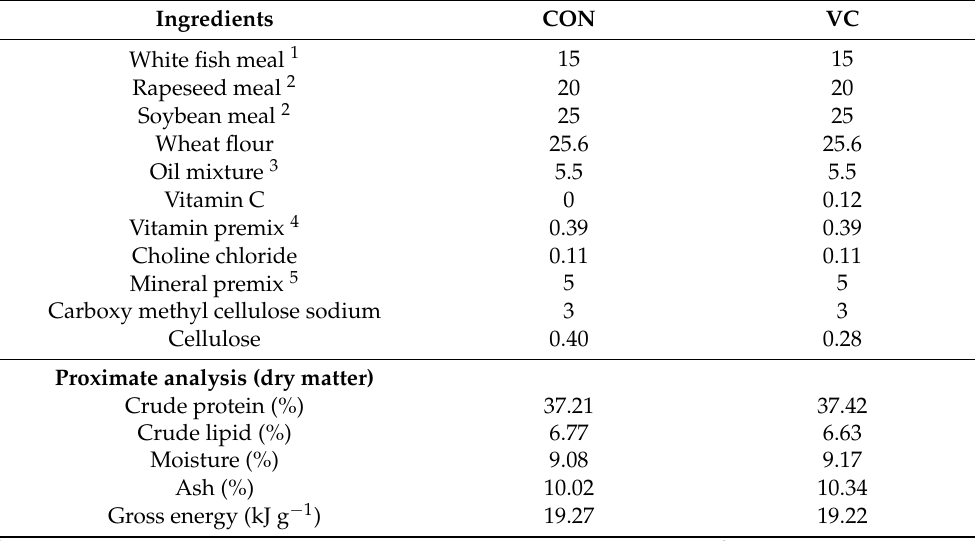
Table 1. Ingredients and proximate composition of the experimental diets (% dry